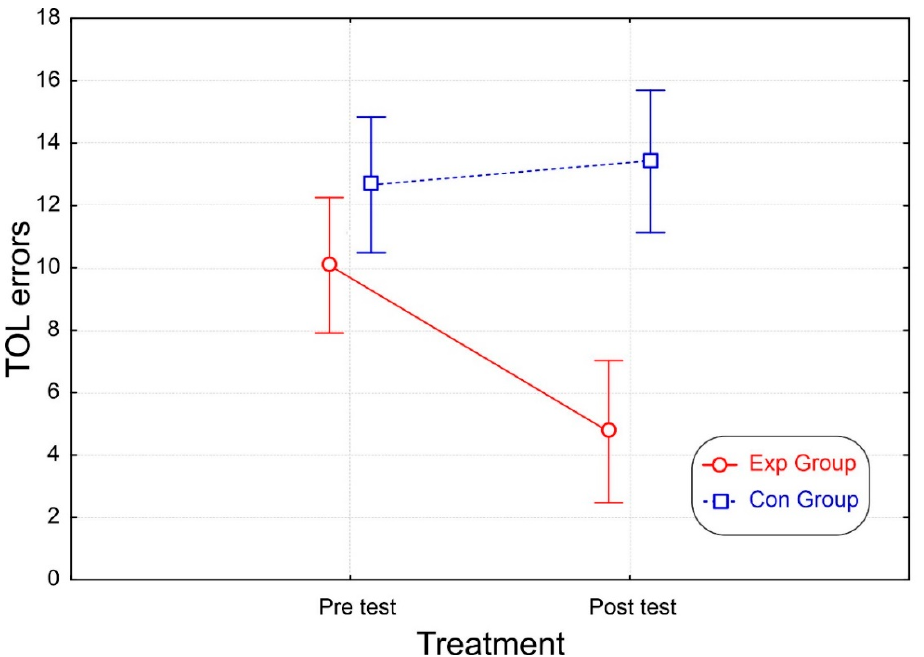
Brain Sci. 2022 , 12 , x FOR PEER REVIEW Figure 6. Results of failed TOL test attempts. The vertical bars denote the 95% confidence interval.